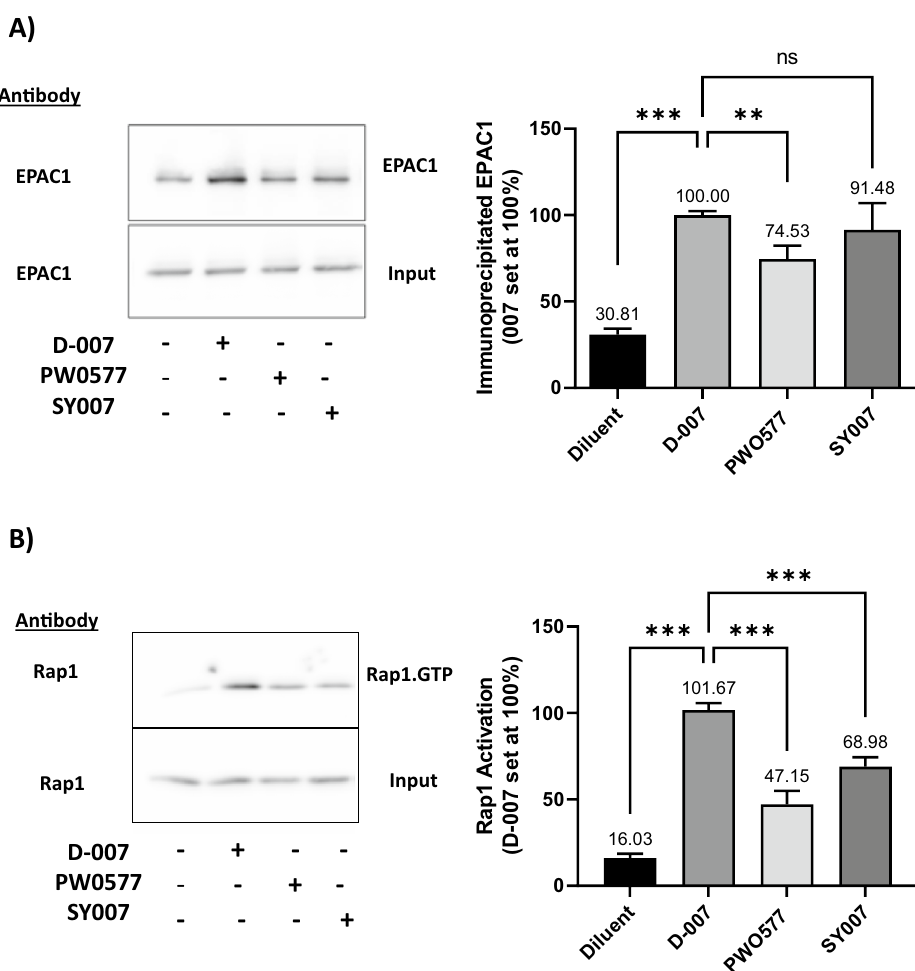
Figure 3. Effects of EPAC1 Activators on EPAC1 and Rap1 Activation. ( A ) U2OS cells transfected with EPAC1 were preincubated for 10 min with 100 μM of EPAC1 activators, PWO577, SY007 or D-007. Active EPAC1 was then isolated from cells by immunoprecipitation with the activation selective EPAC1 (DE3) antibody and detected by immunoblotting with the same antibody, as described in “Materials and methods”. Significant increases in active EPAC1 levels relative to D-007-treated cells are indicated; **p < 0.01 and ***p < 0.001 or ns, for no significant difference (n = 5–7). ( B ) U2OS cells transfected with EPAC1 were preincubated for 10 min with 100 μM of EPAC1 activators, PWO577, SY007 or D-007. Active Rap1 was then isolated from cell lysates, immunoblotted and compared to total Rap1 levels, as described in “Materials and methods”. Data are presented as means ± SEM (n = 5–7). Significant increases in active Rap1 levels in comparison to D-007-treated cells are indicated, p < 0.001 (n =